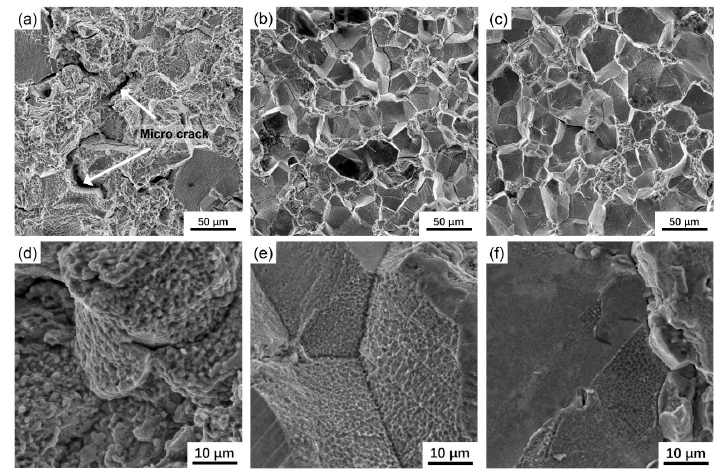
Figure 6. Micro morphology of the initial rupture area. ( a , d ) Furnace cooling; ( b , e ) Air cooling; ( c , f ) Oil quenching. White arrows in ( a ) show the micro cracks.